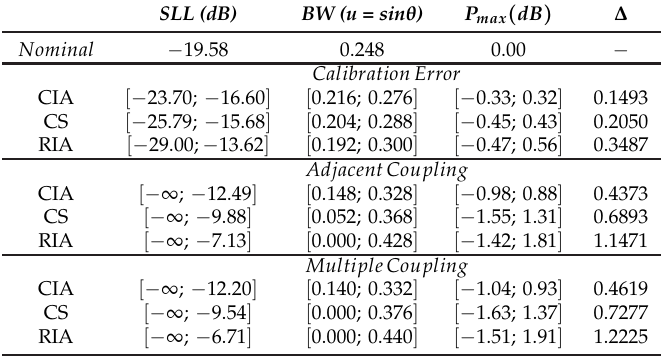
Calibration Errors, Adjacent and Multiple Mutual Coupling ( N = 8, d